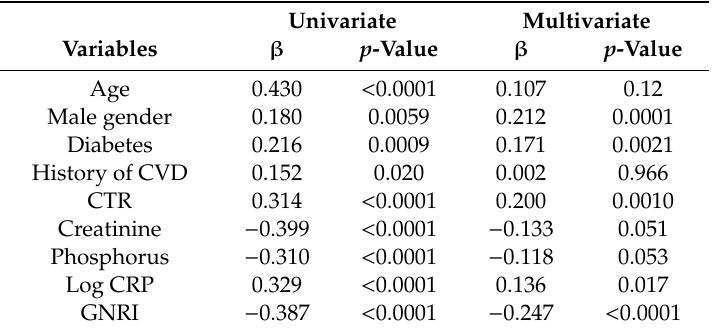
Table 2. Regression analysis of the relationships between the extracellular fluid (ECF) / intracellular fluid (ICF) ratio and baseline